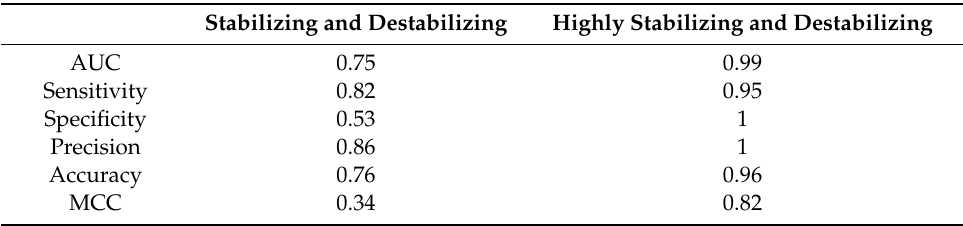
Figure 2. Receiver operating characteristic (ROC) curves for predicting stabilizing / destabilizing and highly stabilizing / highly destabilizing mutations. Table 1. Performance of SAAMBE-3D in predicting stabilizing, destabilizing, highly stabilizing and highly destabilizing mutations.